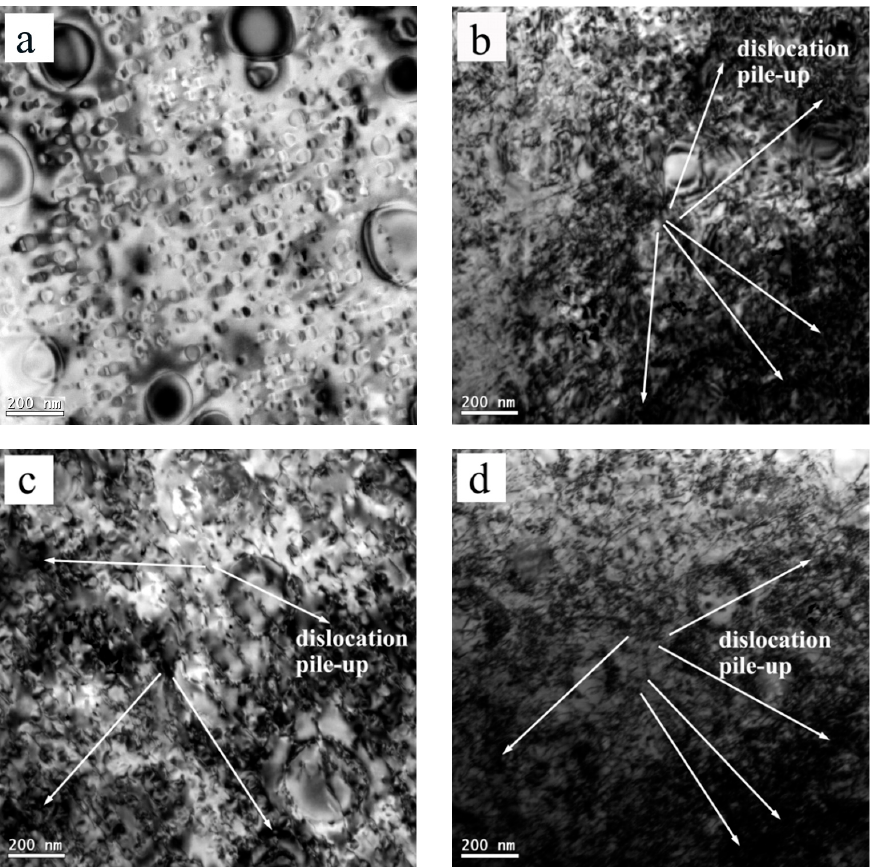
Figure 3. The TEM photos of the superalloy under different deformation conditions: ( a ) initial; ( b ) 1273 K, 70%, 0.1 s − 1 ; ( c ) 1373 K, 70%, 0.1 s − 1 ; ( d ) 1373 K, 70%, 30 s − 1 .